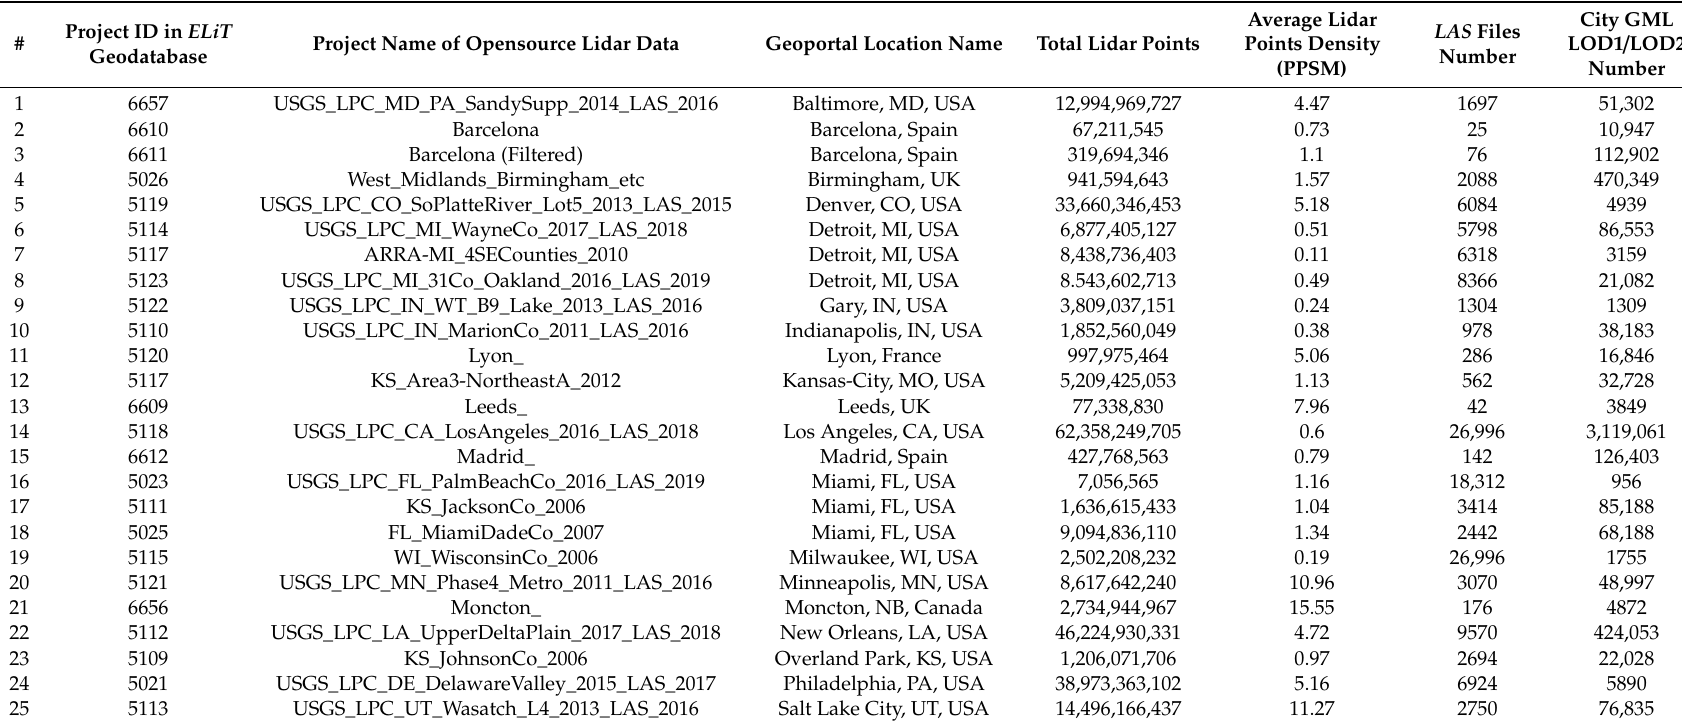
Table 1. Geoportal Key Characteristics of the processed locational projects with the ELiT building models according to CityGML level of detail (LOD) 1 / LOD2